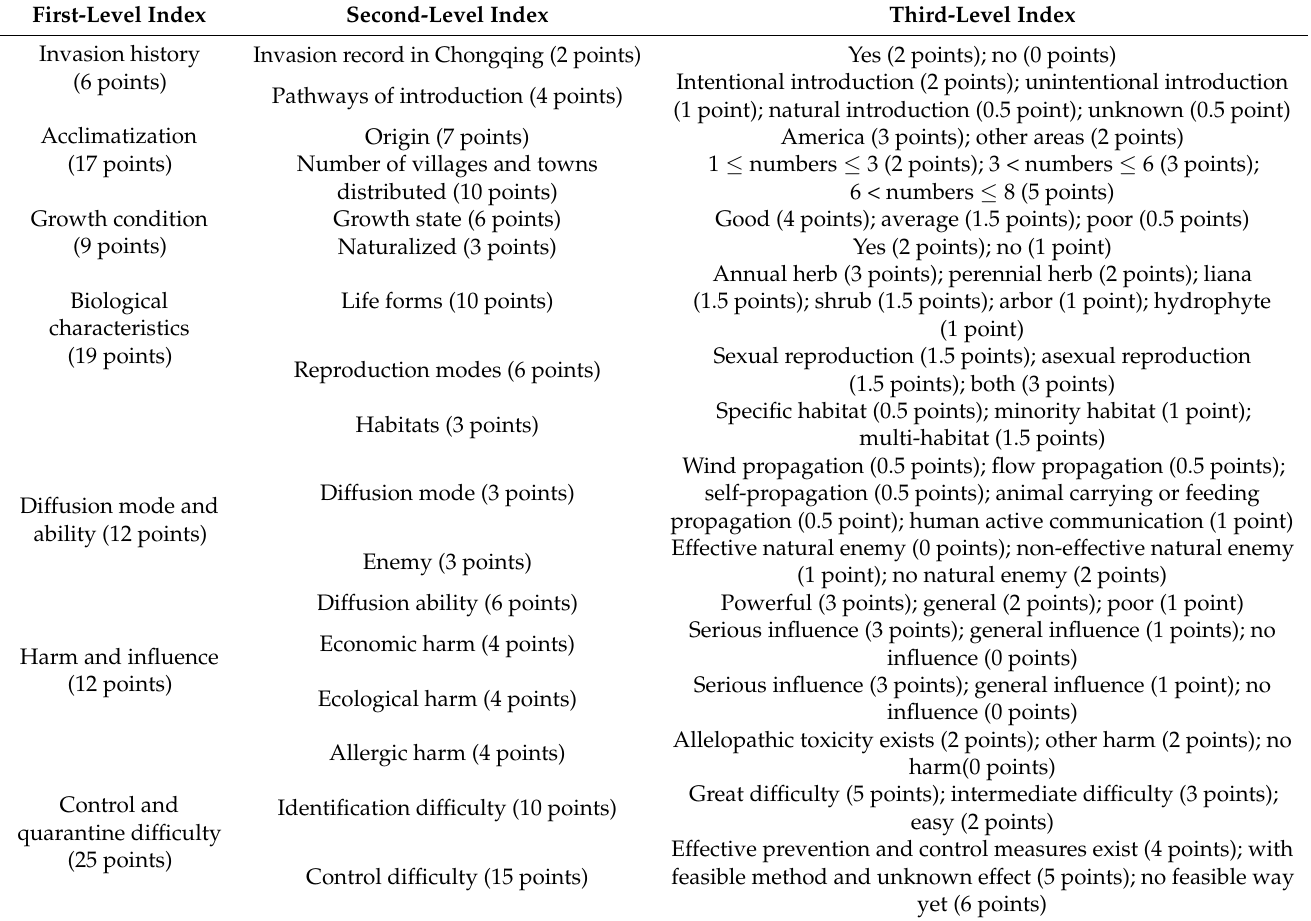
Table 1. The levels of the risk assessment index